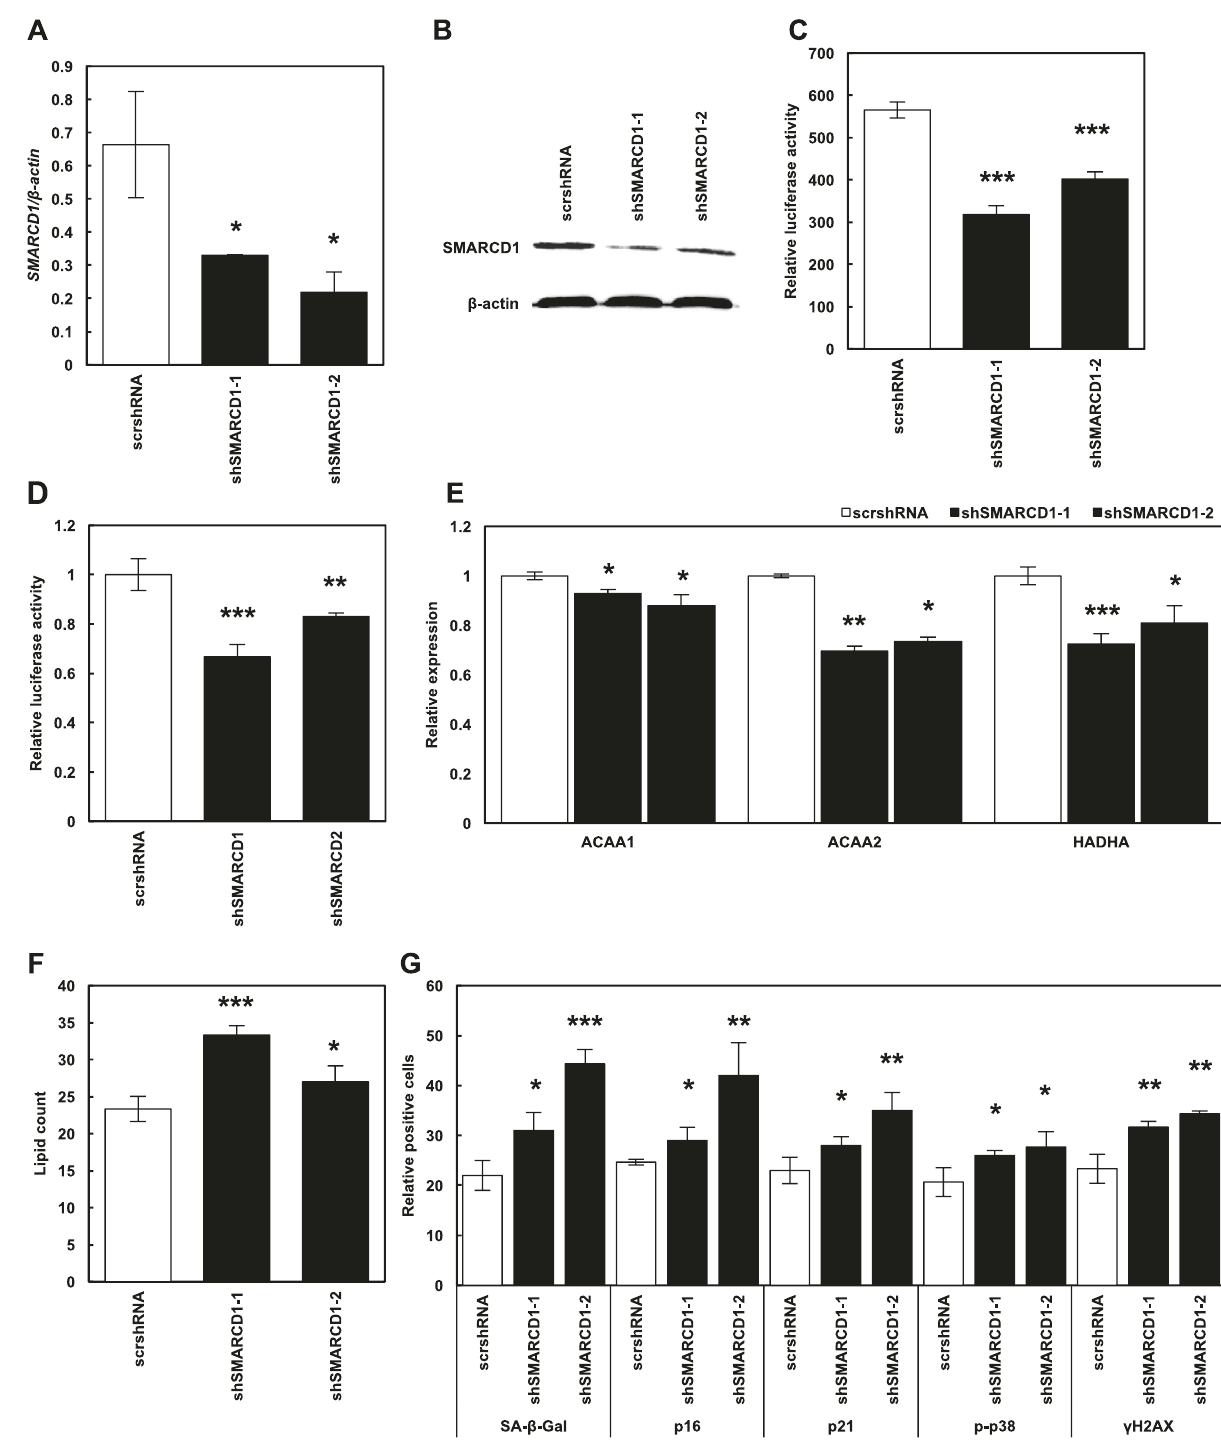
Fig. 3 Lipid accumulation and senescence induction in SMARCD1 -silenced HepG2 cells. ( a ) SMARCD1 relative expression in SMARCD1-silenced HepG2 cells. ( b ) Expression of SMARCD1 in scr-shRNA-transduced and SMARCD1-silenced HepG2 cells. PPAR-dependent transcription ( c ) and transcriptional activation ability of PGC-1 α ( d ) in scr-shRNA-transduced and SMARCD1-silenced HepG2 cells. ( e ) Relative expression of FAO genes in scr-shRNA-transduced and SMARCD1 -silenced HepG2 cells. ( f ) The number of lipid droplet in scr-shRNA-transduced and SMARCD1 - silenced HepG2 cells. ( g ) Activity and expression of senescence markers were measured in scr-shRNA-transduced and SMARCD1-silenced HepG2 cells. Data are expressed as mean ± SD. P < 0.05 was considered statistically signi fi cant ( * P < 0.05; ** P < 0.01; *** P <